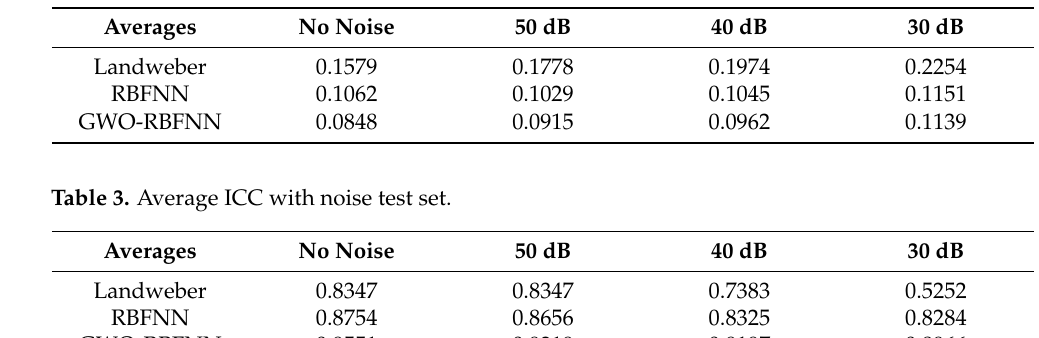
Table 2. Average RMSE with noise test set.